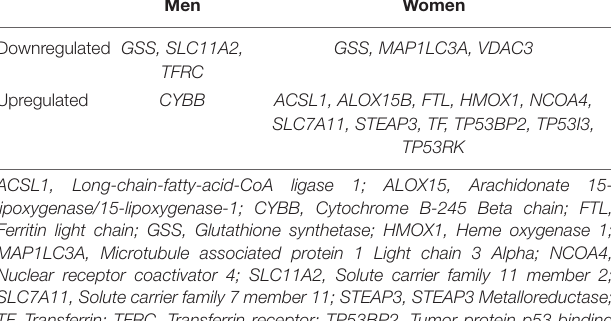
TABLE 3 | Comparison of ferroptosis-related DEGs in AD between genders. Men Women Downregulated GSS, SLC11A2, GSS, MAP1LC3A, VDAC3 TFRC Upregulated